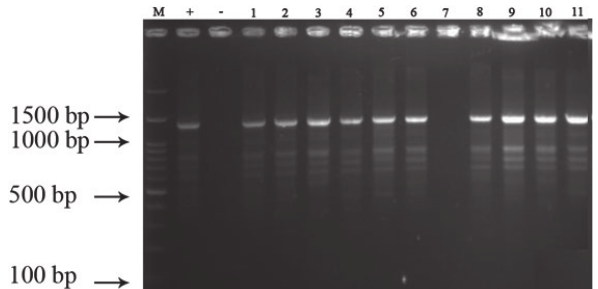
Figure 2. Electrophoresis gel of studied ecotypes from DNA frag- ments produced by SRAP profile; 1,8: H. perforatum ; 2, 9: H. lysi- machioides ; 3,10: H. asperulum ; 4, 11: H. helianthemoides ; 5,12: H. vermiculare ; 6,13: H. hirsutum ; 7,14: H.